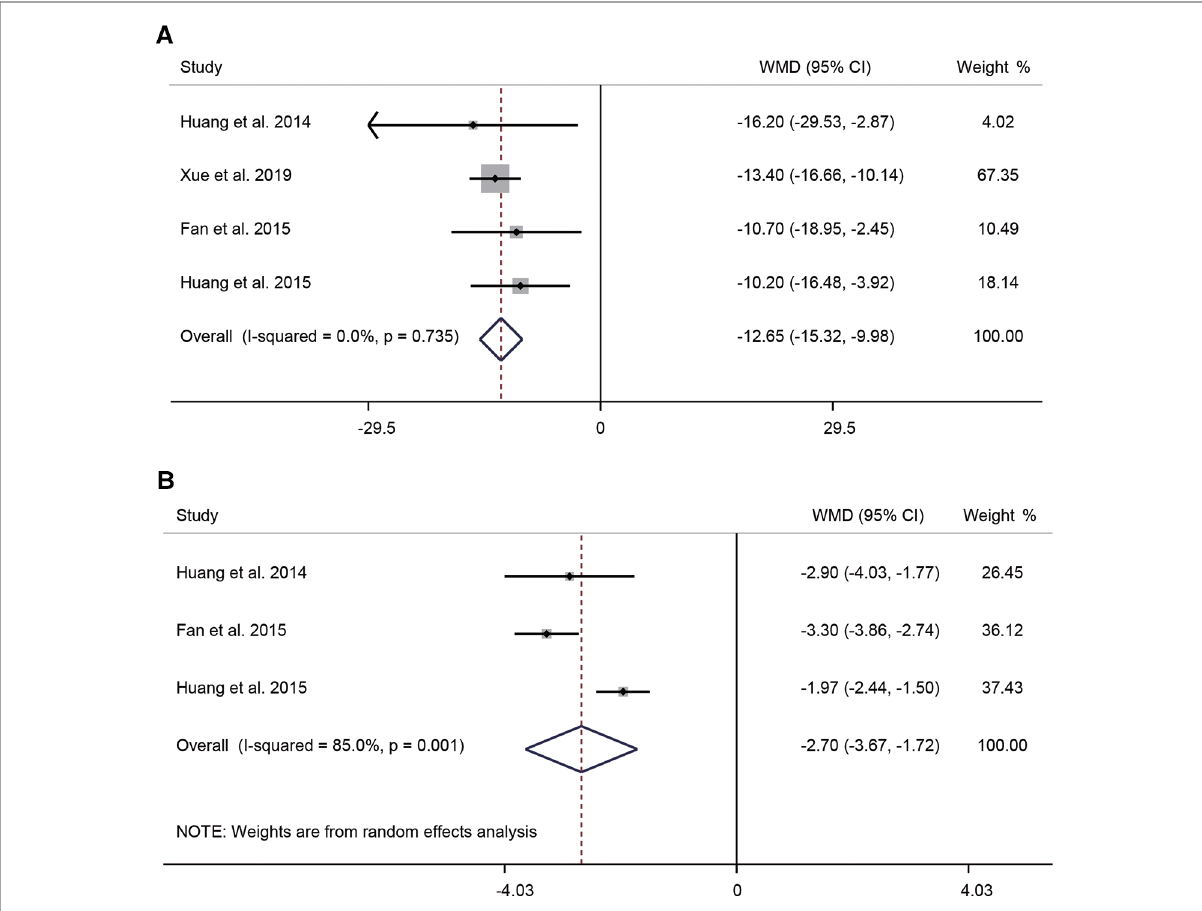
FIGURE 5 Forest plot of operation time ( A ) and number of needle adjustments ( B ) for the comparison of different puncture approaches (other puncture approaches vs. FO). FO, foramen